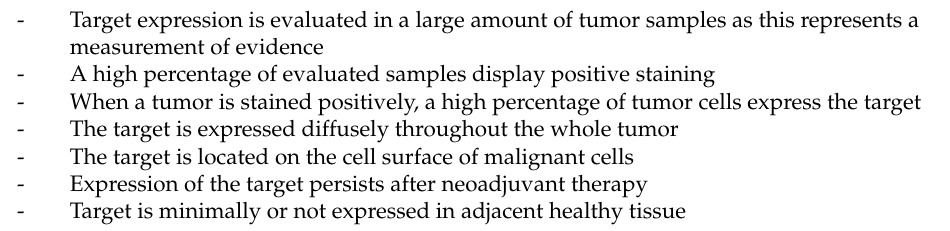
Table 1. Important parameters for target